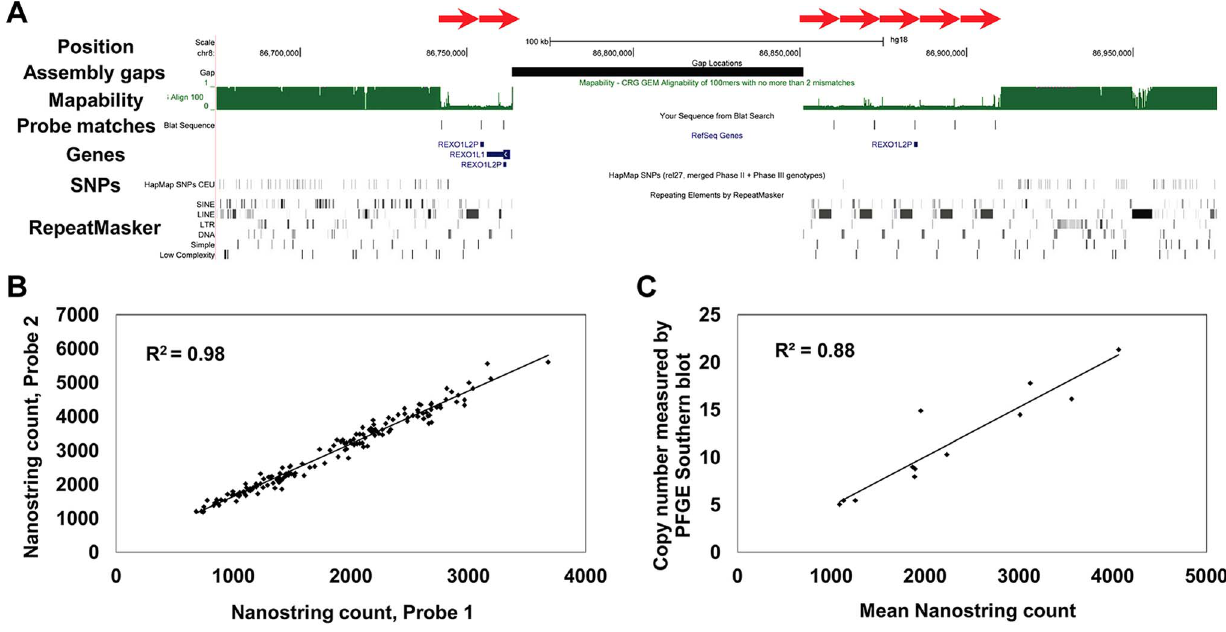
Figure 1. Structure and measurement of tandemly repeated genes using Nanostring assays. ( a ) Multiple copies of the REXO1L1 gene occur as a tandemly repeated cluster in 8q21.2. Although just 4 copies of REXO1L1 are annotated in hg18, at least seven copies of a , 12.2 kb repeat are visible separated by a genome assembly gap ( red arrows ). Our studies show that this locus in fact varies from , 110 to , 250 diploid copies in normal humans. BLAT alignments show one of the two probes used to assay this locus that has a match to each of the annotated repeat copies, in addition to an unassembled copy on chr8_random (Table S1). Note the reduced mapability and almost complete absence of SNPs within the REXO1L1 locus. Screenshot shows a 300 kb region of hg18 (chr8:86,675,000–86,975,000). ( b ) CT47 is another gene present as a tandemly repeated cluster in Xq24. Measurement of CT47 copy number using two independent probes targeted to different parts of the gene show extremely high concordance (R 2 =0.98), indicating that Nanostring probe counts provide accurate measurements that are directly proportional to copy number over a wide dynamic range. ( c ) Direct copy number estimation for CT47 measured by Pulse Field Gel Electrophoresis (PFGE) in 12 individuals shows high concordance with Nanostring probe counts (R 2